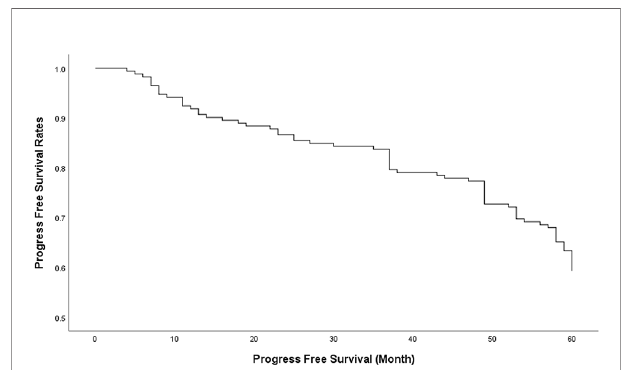
FIGURE 1 | The overall progress free survival (PFS) rates of 1, 3 and 5 years after transnasal sphenoidal surgery was 90.70%, 79.65% and